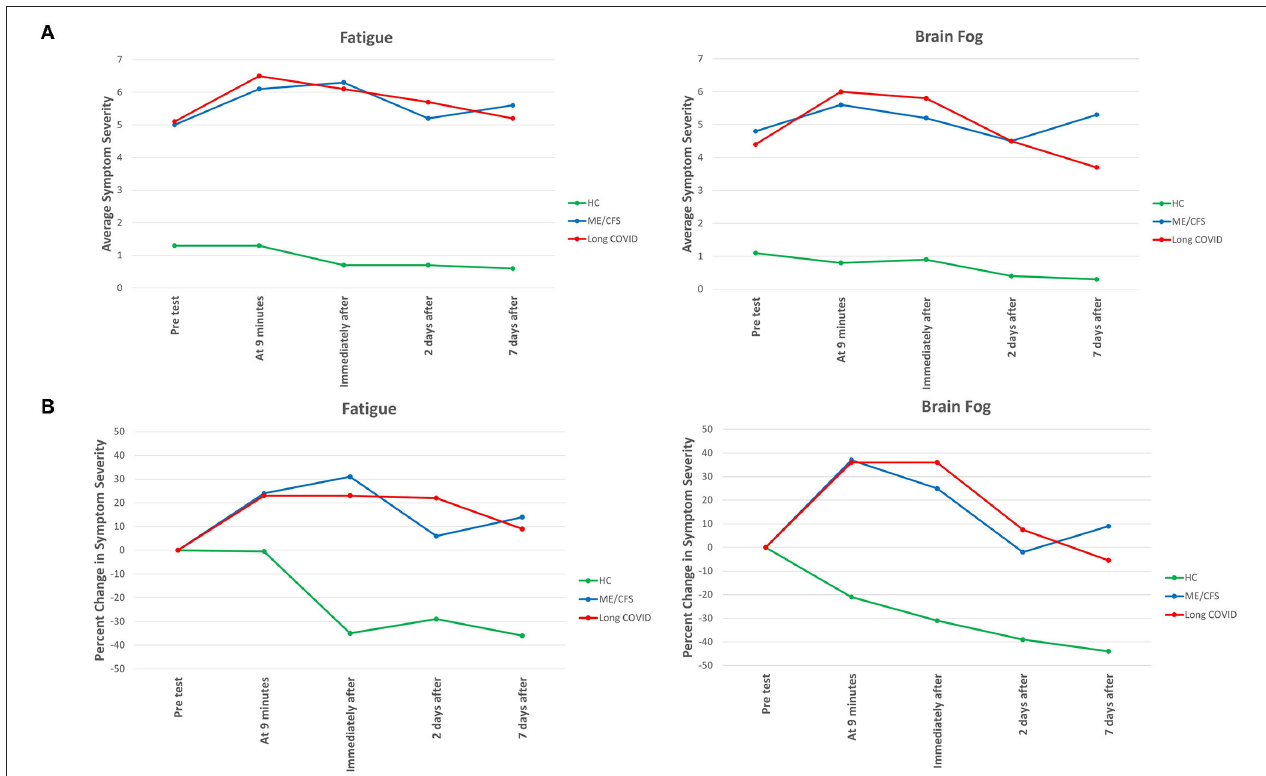
FIGURE 1 | Severity of fatigue and brain fog at different time points before, during and after NASA Lean Test in Long COVID, ME/CFS and healthy control subjects. In (A) , the absolute severity level at each time point is displayed. In (B) , the percent change from just before the Test at each of the different time points is displayed. In (A) , all differences between the two patient groups and the healthy control subjects are statistically significant ( p < 0.001). In (B) , the same is true for each time point during and following the